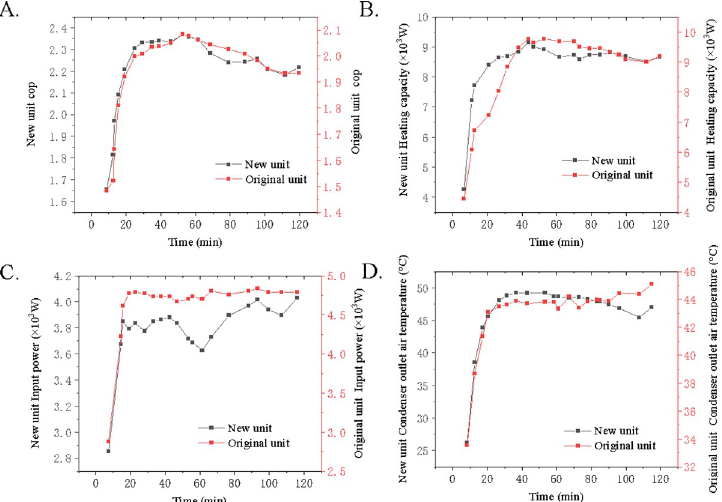
Fig 11. Heat transfer characteristics under working condition 2 at different times. Fig A: the training data set, Fig B: the verification data set, Fig C: the test data set, and Fig D: the sum test result of all data.